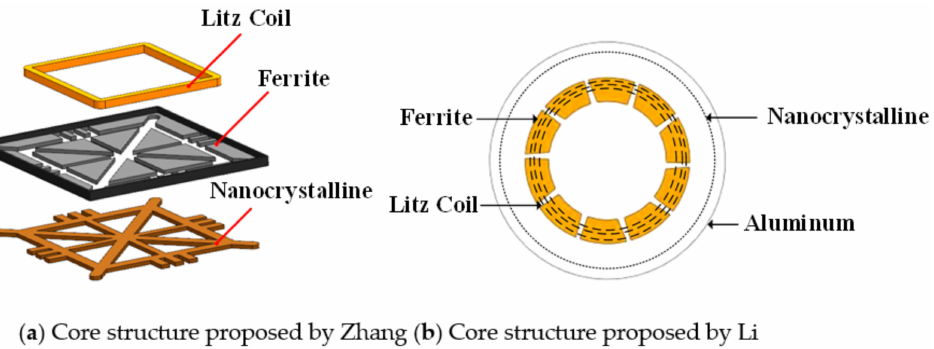
Figure 22. ( a , b ) Two types of embedded magnetic structures with nanocrystalline and